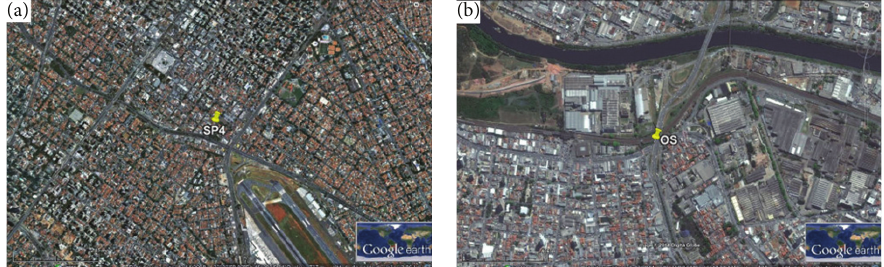
Figure 6: Image of stations. (a) SP4, the airport is at the lower right corner (source: Google Earth, 14 Dec 2008, 08 Dec 2014) and (b) OS (source: Google Earth, 22 Sep 2014, 08 Dec